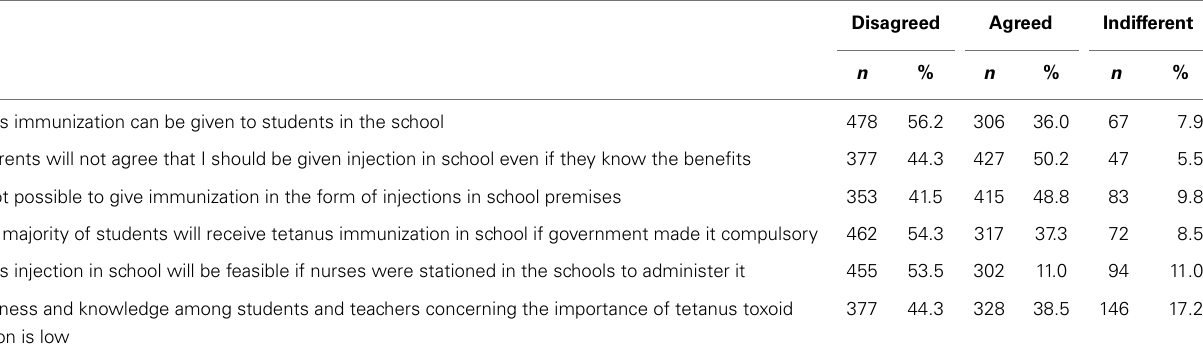
Table 4 | Opinions of high school girls about tetanus vaccination in the school premises